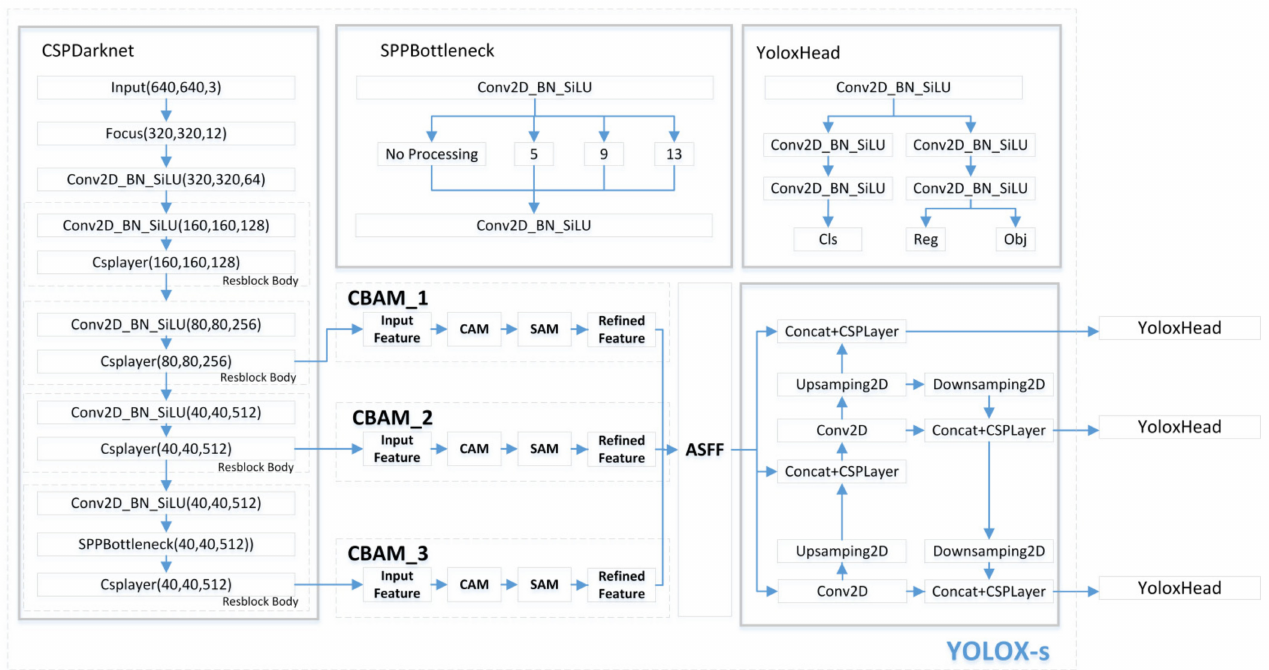
Figure 4. Implementation flow of YOLOX inserting CBAM and ASFF modules. Reg represents the loss function of location; Obj represents the loss function of determining part for positive samples; Cls represents the loss function of